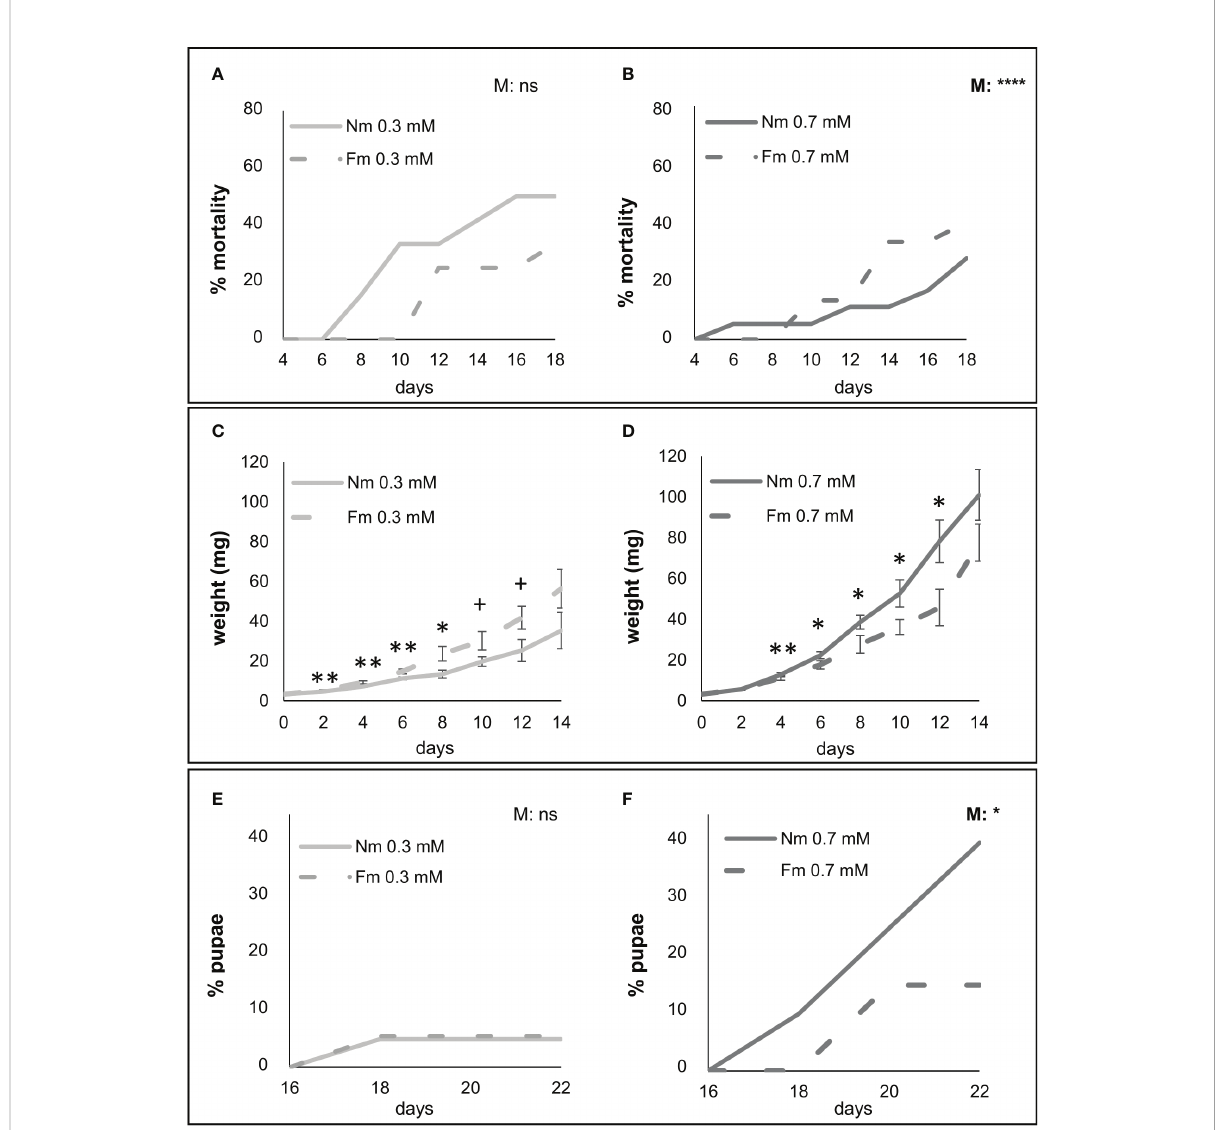
FIGURE 2 Impact of mycorrhiza on herbivore performance under different P availability. S. exigua performance of larvae fed on leaves of mycorrhizal (Fm, dotted line) and non-mycorrhizal (Nm, continuous line) plants fertilized with 0.3 or 0.7 mM of P, light and dark grey, respectively; (n=9). Six- weeks post-inoculation with F. mosseae (Fm), plants were infested with second instar S. exigua larvae (two per plant, n=18 per treatment) using a clip-cage to con fi ne the larvae to a lea fl et. Infestation was maintained for three weeks by moving the clip-cage every two days. (A, B) S. exigua mortality (C, D) weight and (E, F) individuals reaching pupa stage. Statistical analyses were performed independently for each P fertilization level: (A, E) 0.3 mM and (B, F) 0.7 mM. (A – F) P values in the upper right corner of each graph indicate statistically differences in mortality and pupation between Nm and Fm, according to Log-rank (Mantel-Cox) test. For larval biomass (C, D), values are the weight mean of survived larvae ± SD. Asterisks indicate signi fi cant differences between Nm and Fm treatments at given time point according to t-test. ns: no signi fi cant; +:p < 0.1; *:p < 0.05; **:p < 0.01; ***:p < 0.001;